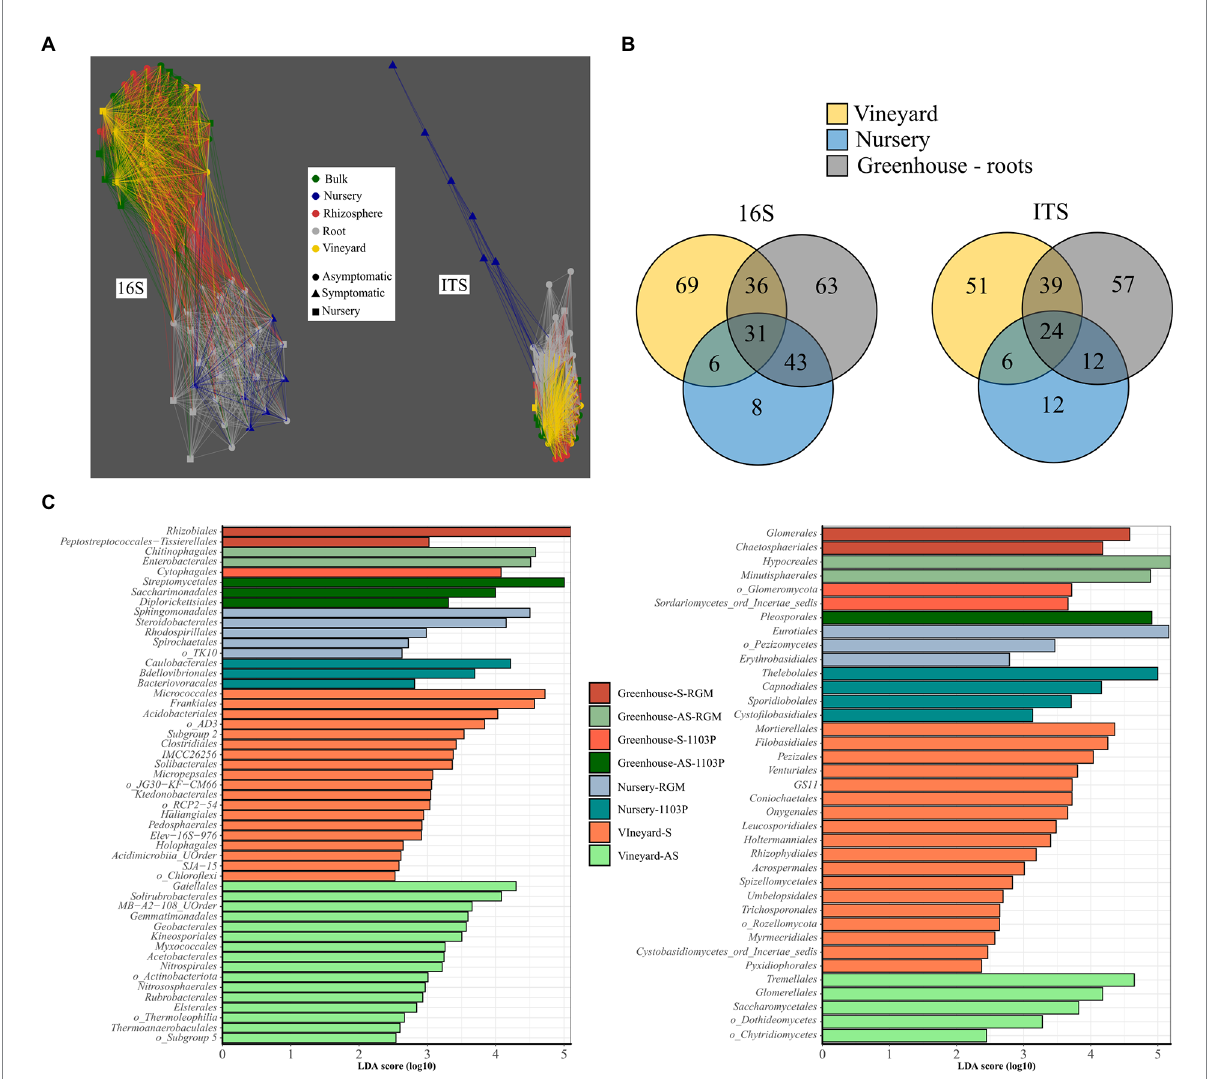
FIGURE 4 The contribution of vineyard and nursery microbiomes to root associated microbiome in the greenhouse disposal. (A) Network analysis of bacterial (16S rRNA gene) and fungal (ITS) taxa, in terms of relative abundance, in vineyard soils, roots from nursery plants before planting, and greenhouse compartments (i.e., bulk, rhizosphere, root), using Bray–Curtis distances less than 0.95. (B) Venn diagram presenting the number of shared and specific bacterial and fungal genera in vineyard soils, nursery plants, and root compartment from the greenhouse disposal. (C) LEfSe displaying the enriched orders in vineyard soils (symptomatic (S) and asymptomatic A(S)), nursery plant roots (1103P and RGM rootstocks grafted with CS), and root compartments from greenhouse experiment in each condition (AS-1103P, S-1103P, AS-RGM, S-RGM). Bacteria are in the left and fungi on the